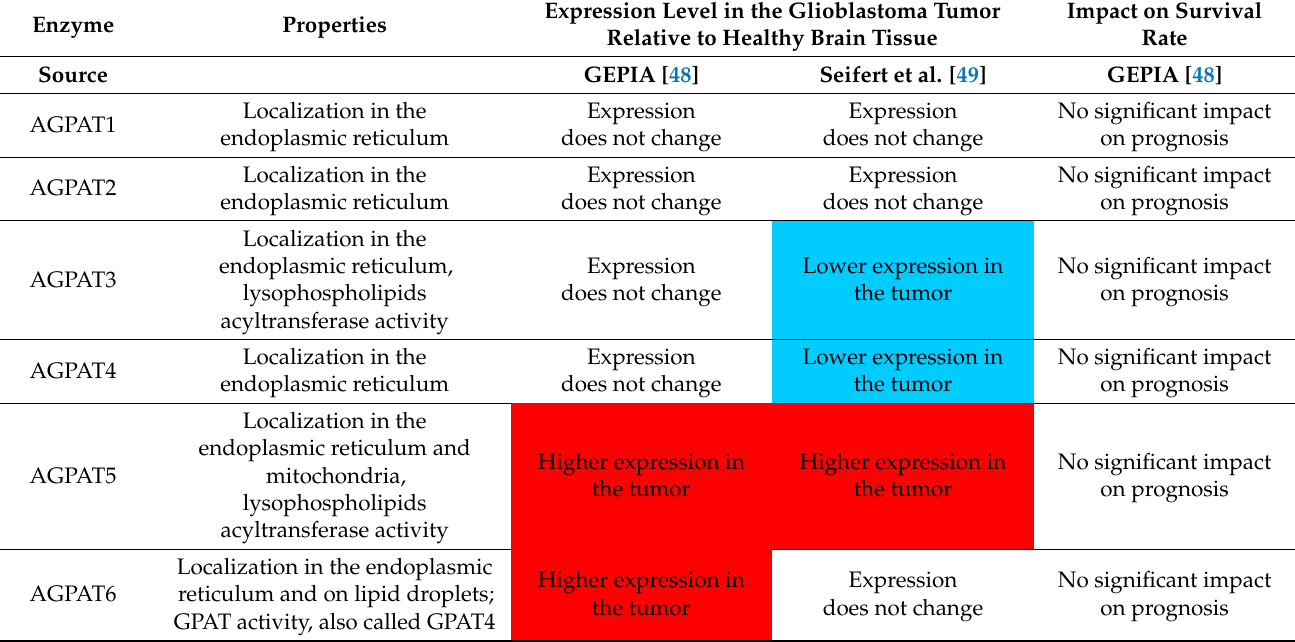
Table 5. Characteristics of AGPAT, enzymes involved in the biosynthesis of phosphatidic acid from lysophosphatidic